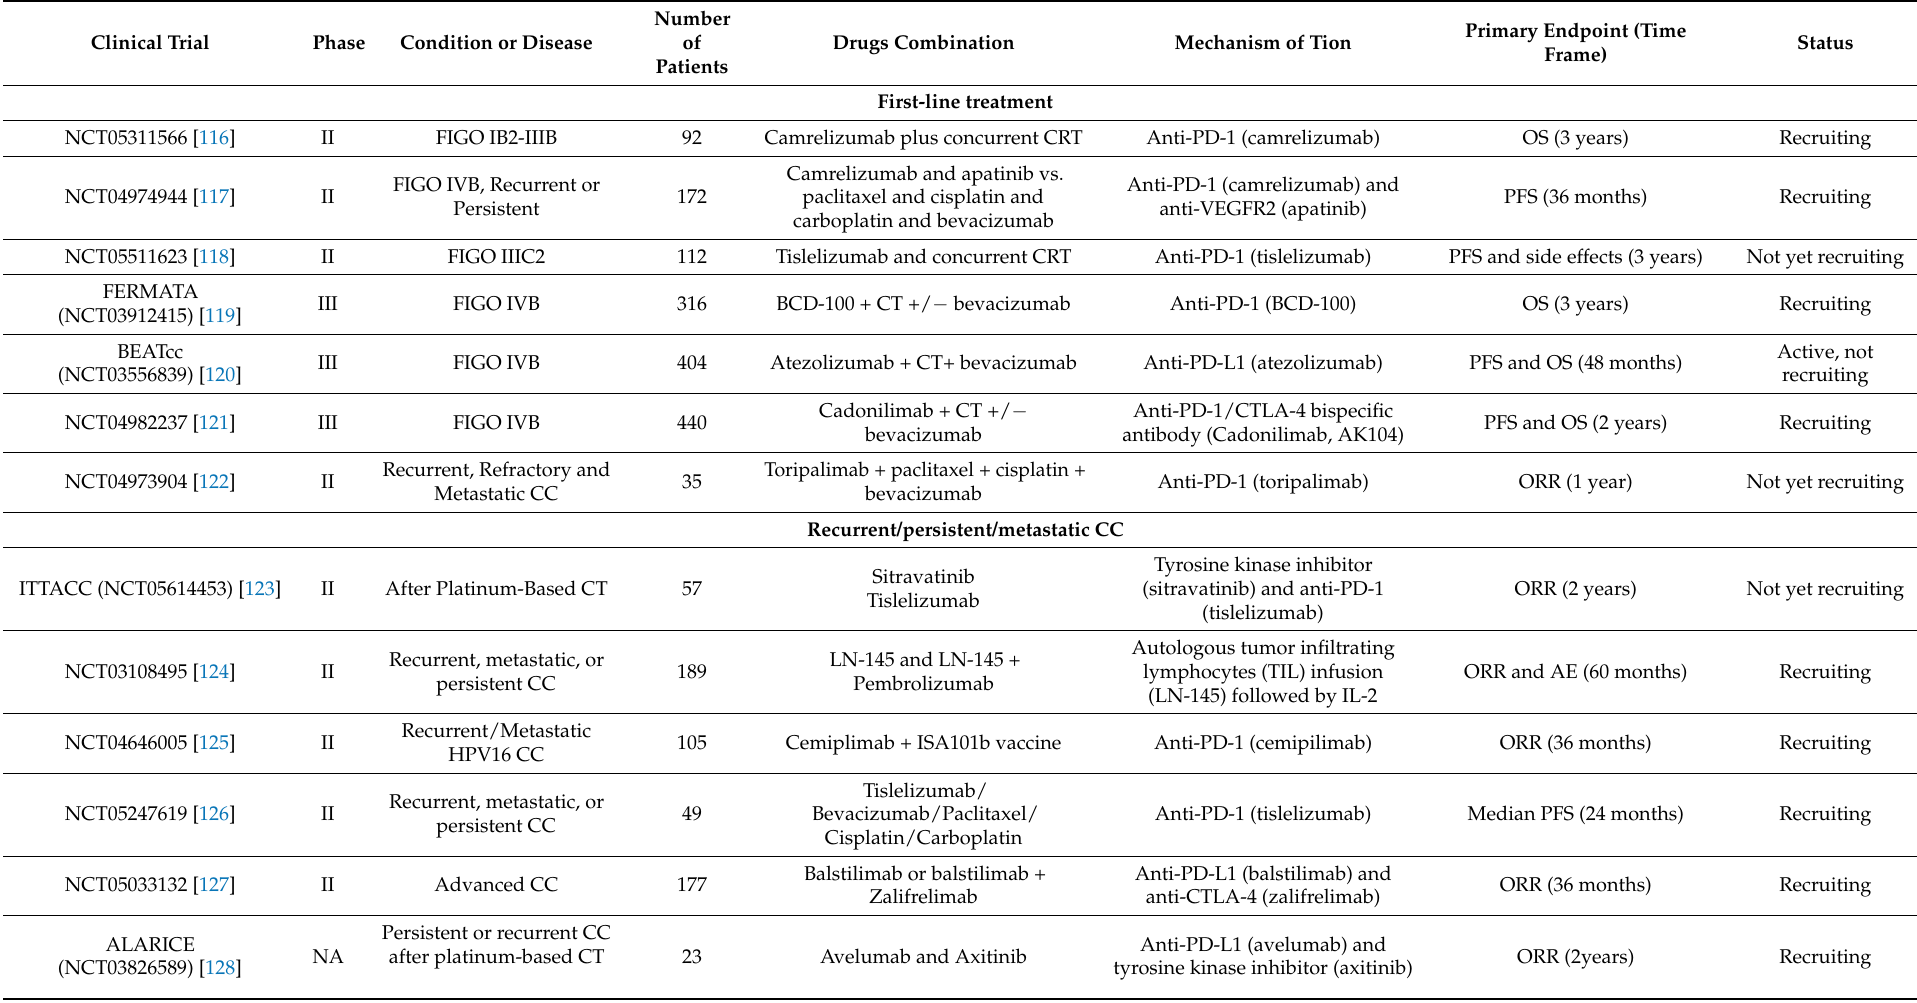
Table 6. Ongoing clinical trials testing immunotherapies alone or in combination in cervical cancer. CC, cervical cancer; CT, chemotherapy; CRT, chemoradiotherapy; ORR, overall response rate; OS, overall survival; PFS, progression-free